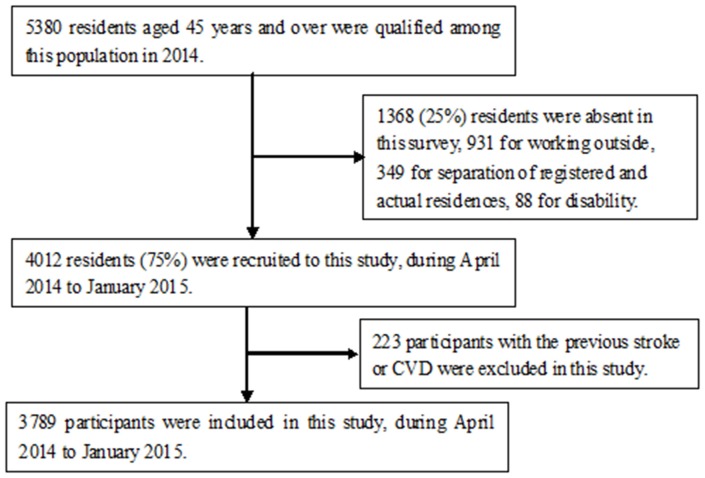
Flow chart of participants.